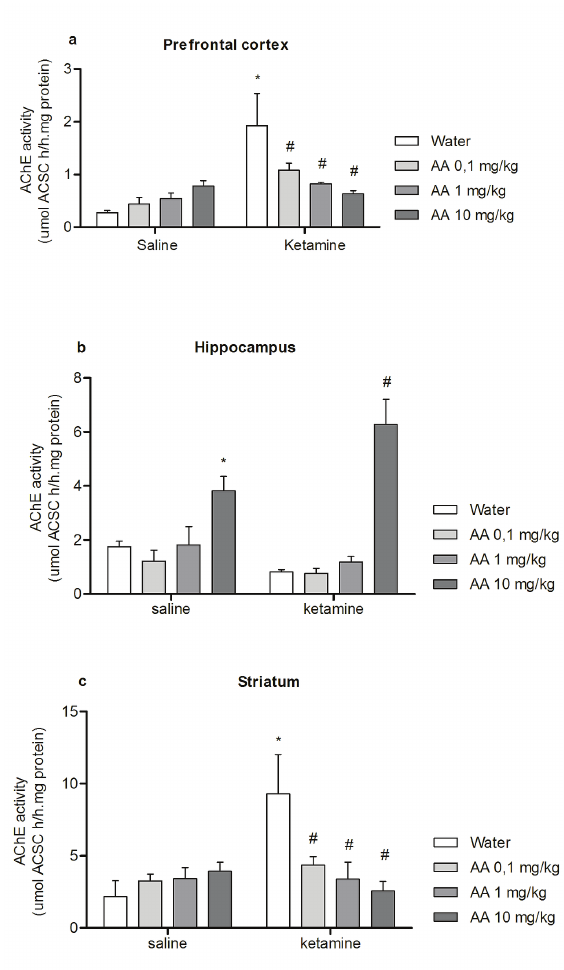
Figure 2 - Activity of the enzyme AchE. The effect of supplementation with AA (0.1, 1 to 10 mg/kg, p.o) on the activity of the enzyme AchE within different brain structures: panel a (prefrontal cortex); panel b (hippocampus) and panel c (striatum) in an animal model of SZ induced by Ket (25 mg/ kg, i.p). Data are expressed as mean ±SEM (N=5-6); * p <0.01 difference from the Water+Sal (control group); # p <0.01 difference from the Water+Ket